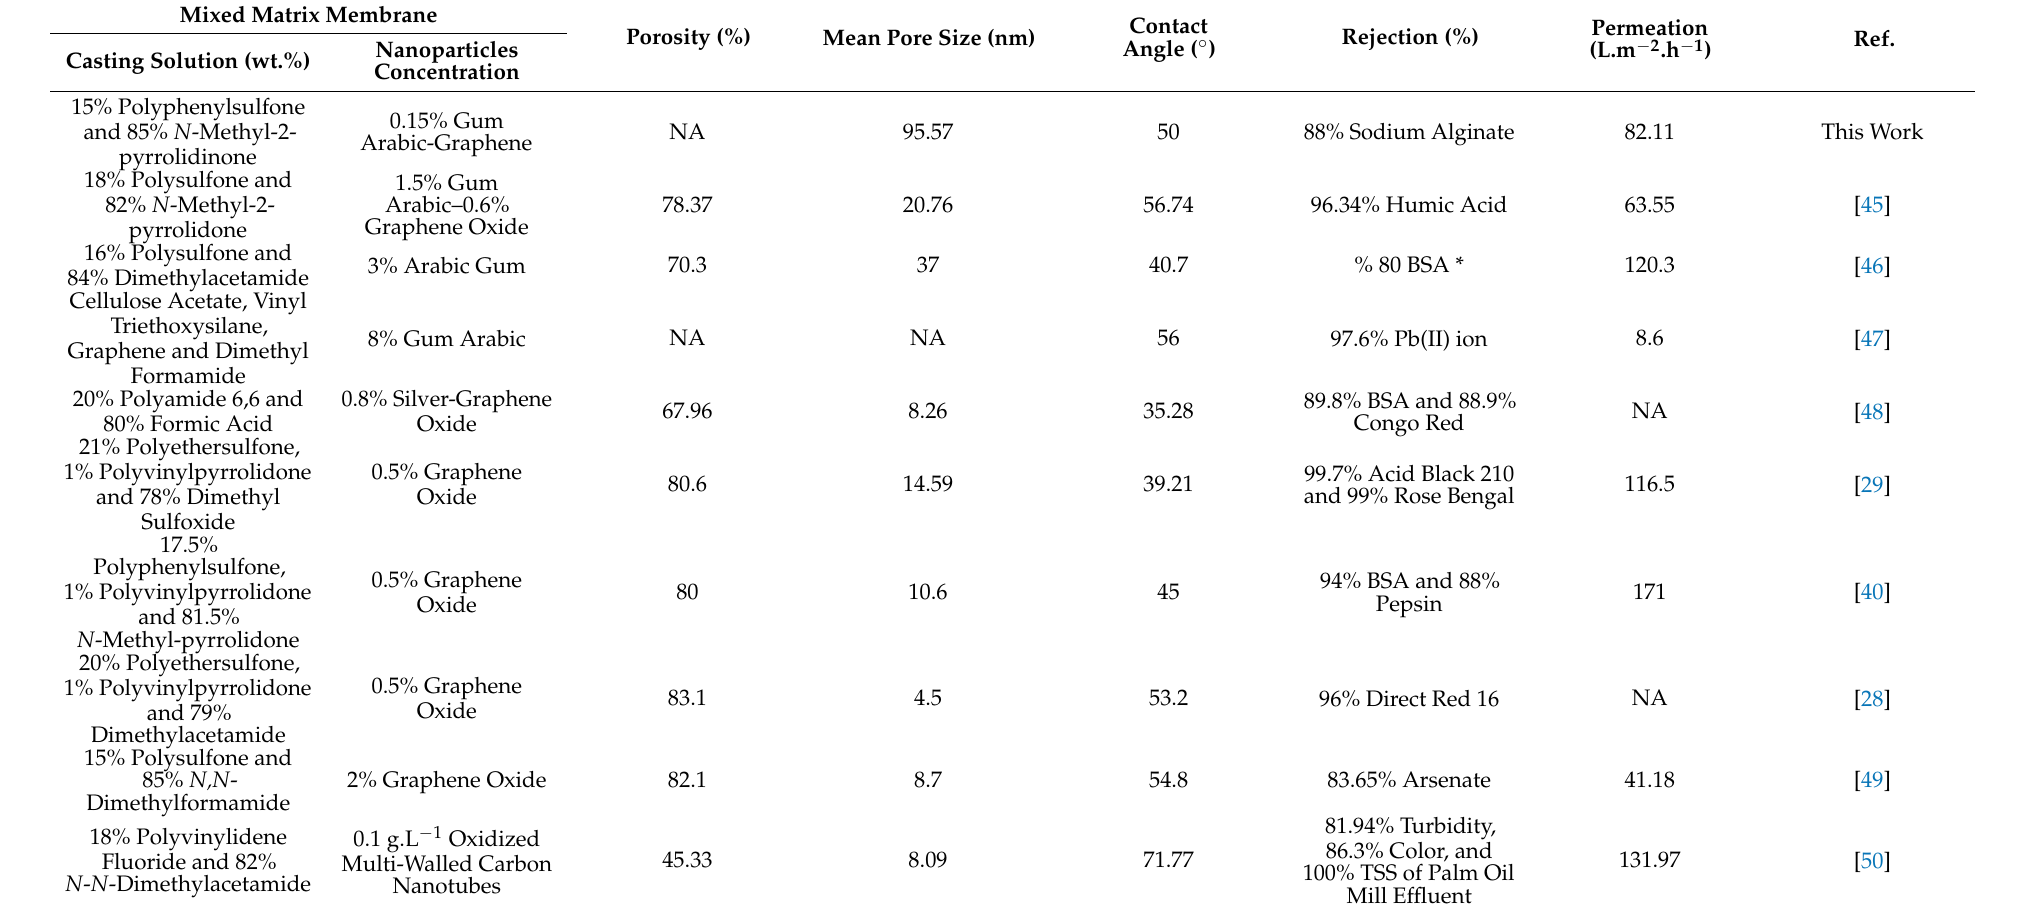
Table 3. Demonstrates the comparison of this work with the recently published work selected from the literature. Mixed Matrix